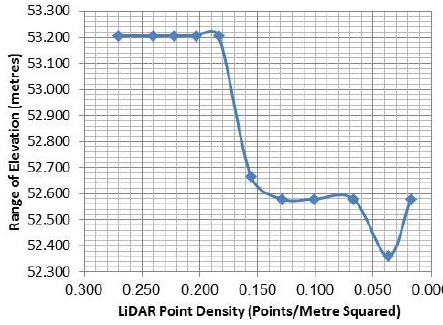
Figure 18. 3D view for a DEM created from reduced LiDAR data down to point cloud density of 0.017pts/m 2 .